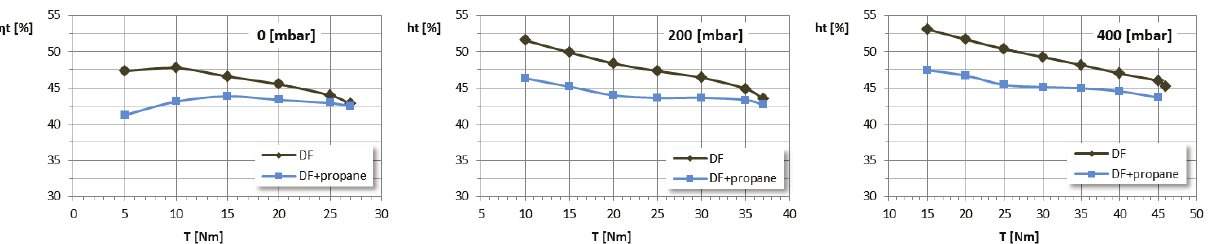
Fig. 2. Load characteristics of thermal efficiency for investigated engine versions